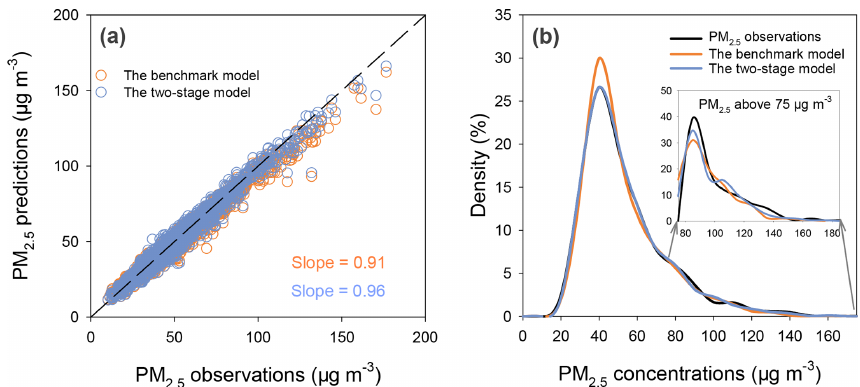
Figure 2. Comparisons between the two-stage model and the benchmark model. (a) The scatter plot of the two-stage model predictions and the benchmark model predictions against ground observations in the fivefold cross-validation (CV). (b) Density distributions of the two-stage model predictions, the benchmark model predictions, and the PM 2 . 5 observations in the fivefold CV.